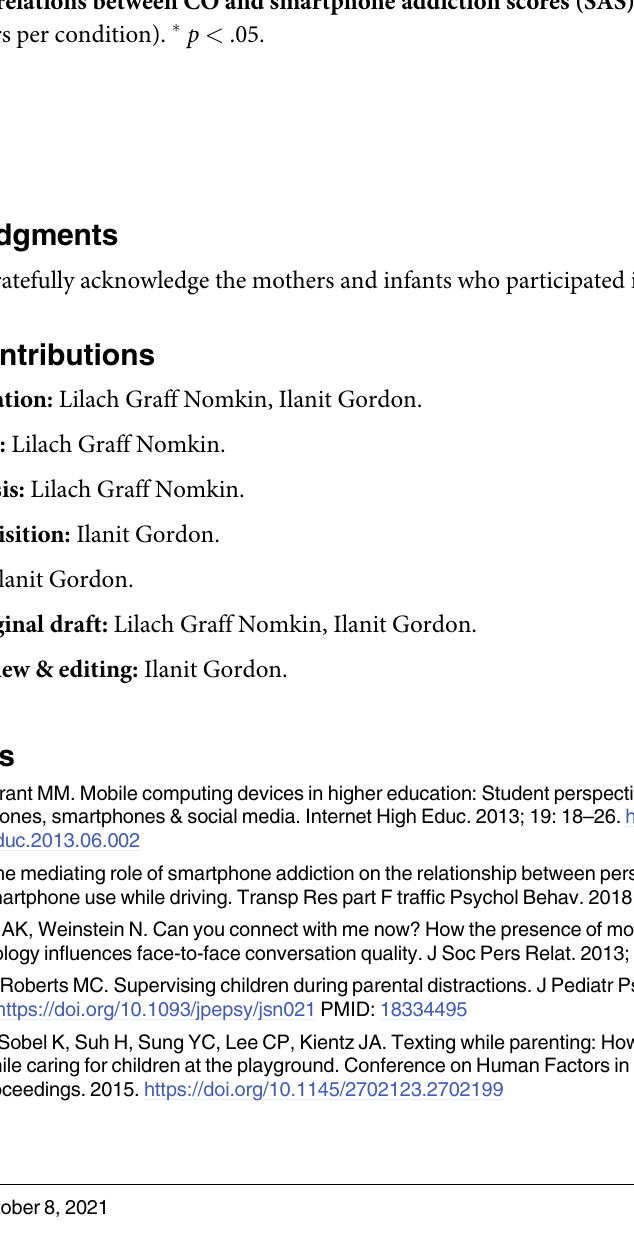
S1 Table. Correlations between tonic SCL and smartphone addiction scores (SAS). Tonic SCL = Tonic Skin Conductance Level, measured in microSiemens. � p < .05. S2 Table. Correlations between tonic period and smartphone addiction scores (SAS). � p < .05. S3 Table. Correlations between CO and smartphone addiction scores (SAS). CO = Cardiac output (in liters per condition). � p <